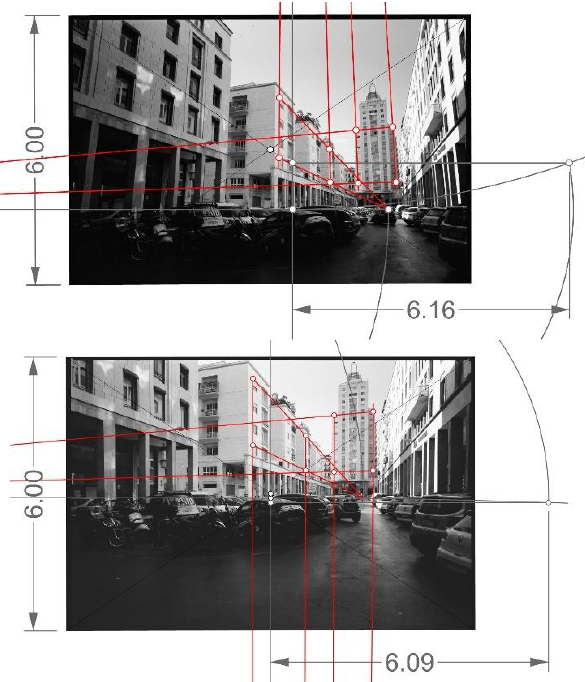
Figure 11: Inner orientation of View Camera’s images.